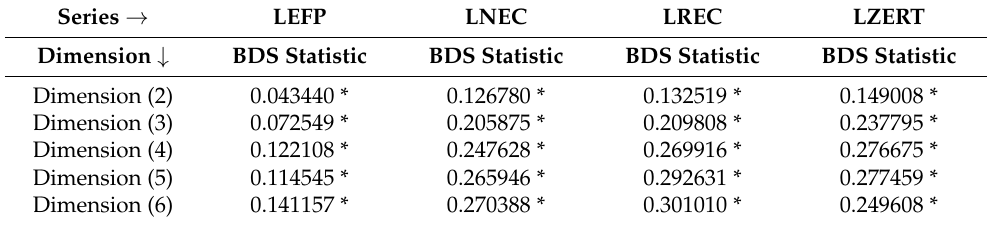
Table 7. BDS test for nonlinearity.